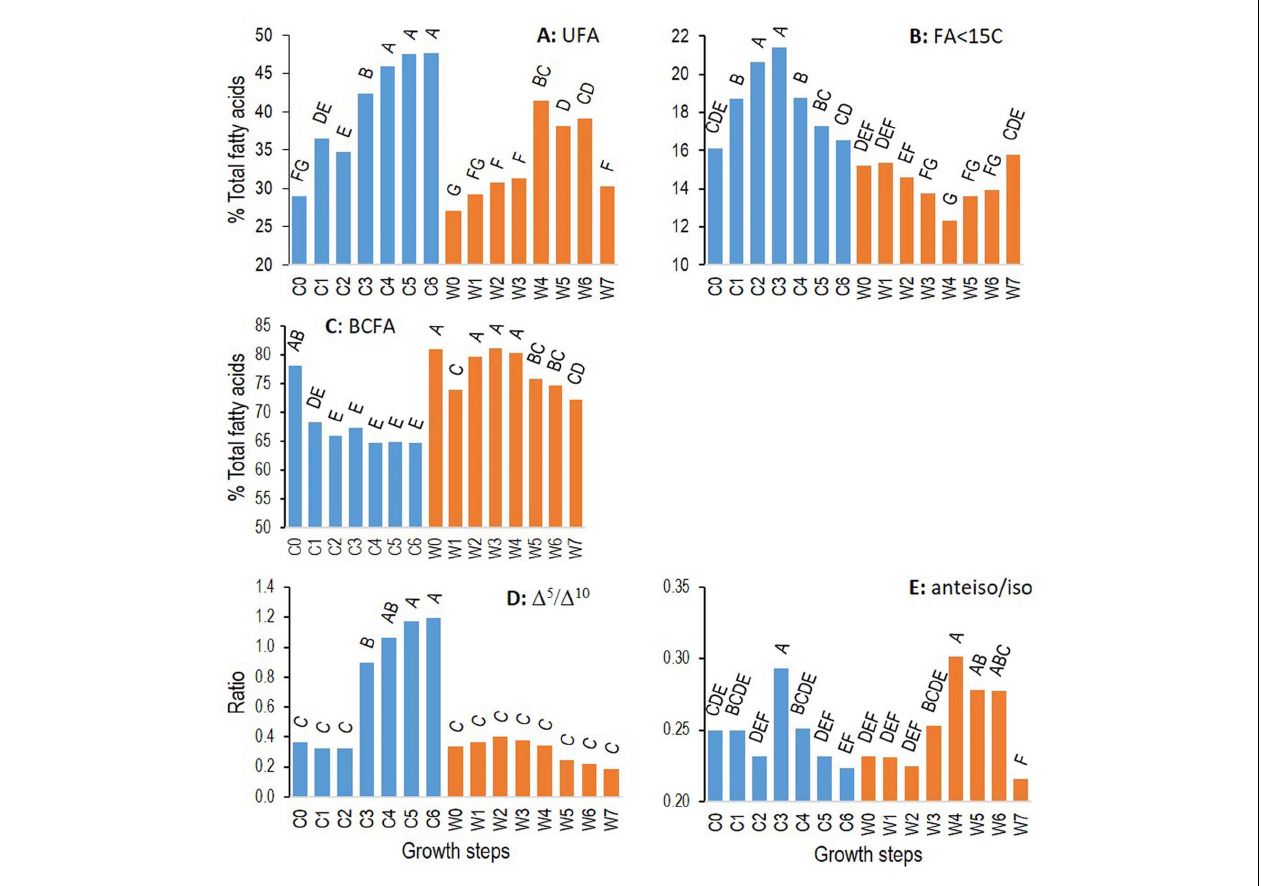
FIGURE 6 | Changes for ATCC 10876 strain of B. cereus at cold (12 ◦ C, C0–6, blue bars) and warm (30 ◦ C, W0–7, orange bars) temperatures of relative abundance of total unsaturated fatty acids (A) , of fatty acids with less than 15 carbons (B) , of relative abundance of total branched-chain fatty acids (C) , of ratio (cid:49) 5 to (cid:49) 10 monounsaturated fatty acids (D) , and of ratio anteiso to iso branched-chain fatty acids (E) . Growth times C0–6 and W0–7 correspond to, respectively, 0, 3, 7, 24, 48, 72, and 96 h and 0, 0.5, 1, 2, 4, 6, 7, and 24 h. Results are mean of three independent experiments. In each panel, bars sharing same letter are not significantly different according to Tukey’ honest significant difference test at the 5% level.